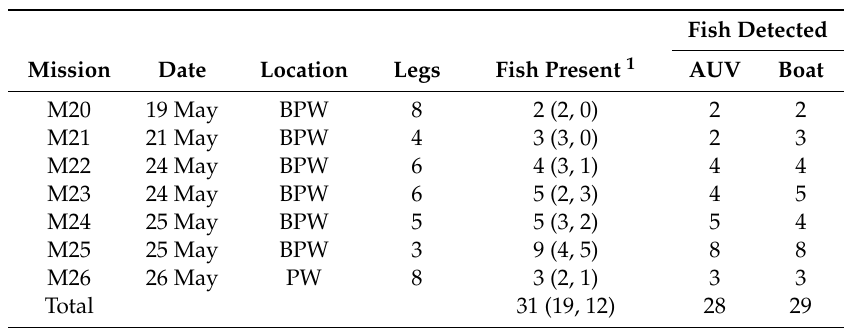
Table 1. Numbers of acoustically tagged Chinook salmon located during survey missions conducted concurrently with an autonomous underwater vehicle and boat in marine waters of Big Port Walter (BPW) and Port Walter (PW), Alaska, during 2016. The total number of fish present and detected in the area (including those released as part of the mission and those remaining from previous releases) are indicated.